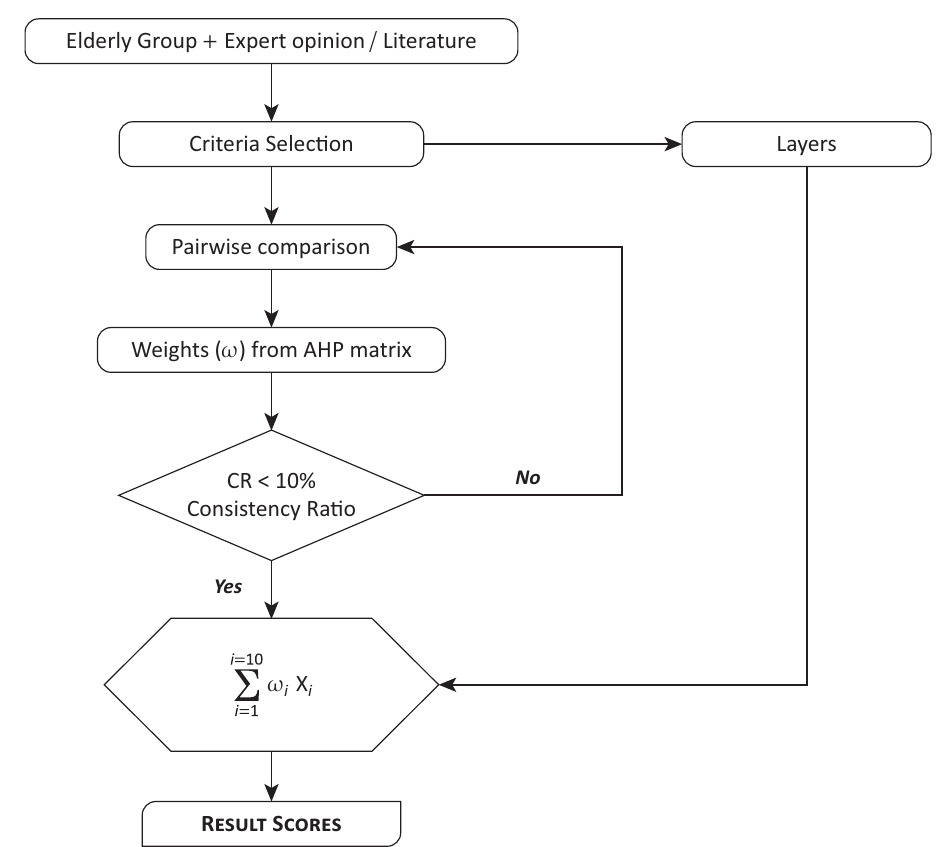
Figure 2. Flow chart of the proposed AHP approach. Notes: X centres, primary health care centres, pharmacies and transportation network, ATMs, parks, and stops; ω of Criteria.